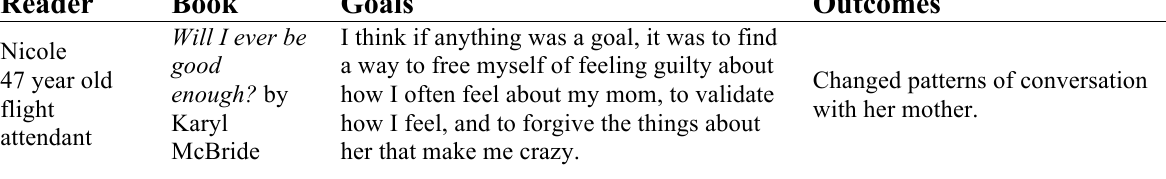
Table 8 : Female self-help reading and relationships Reader